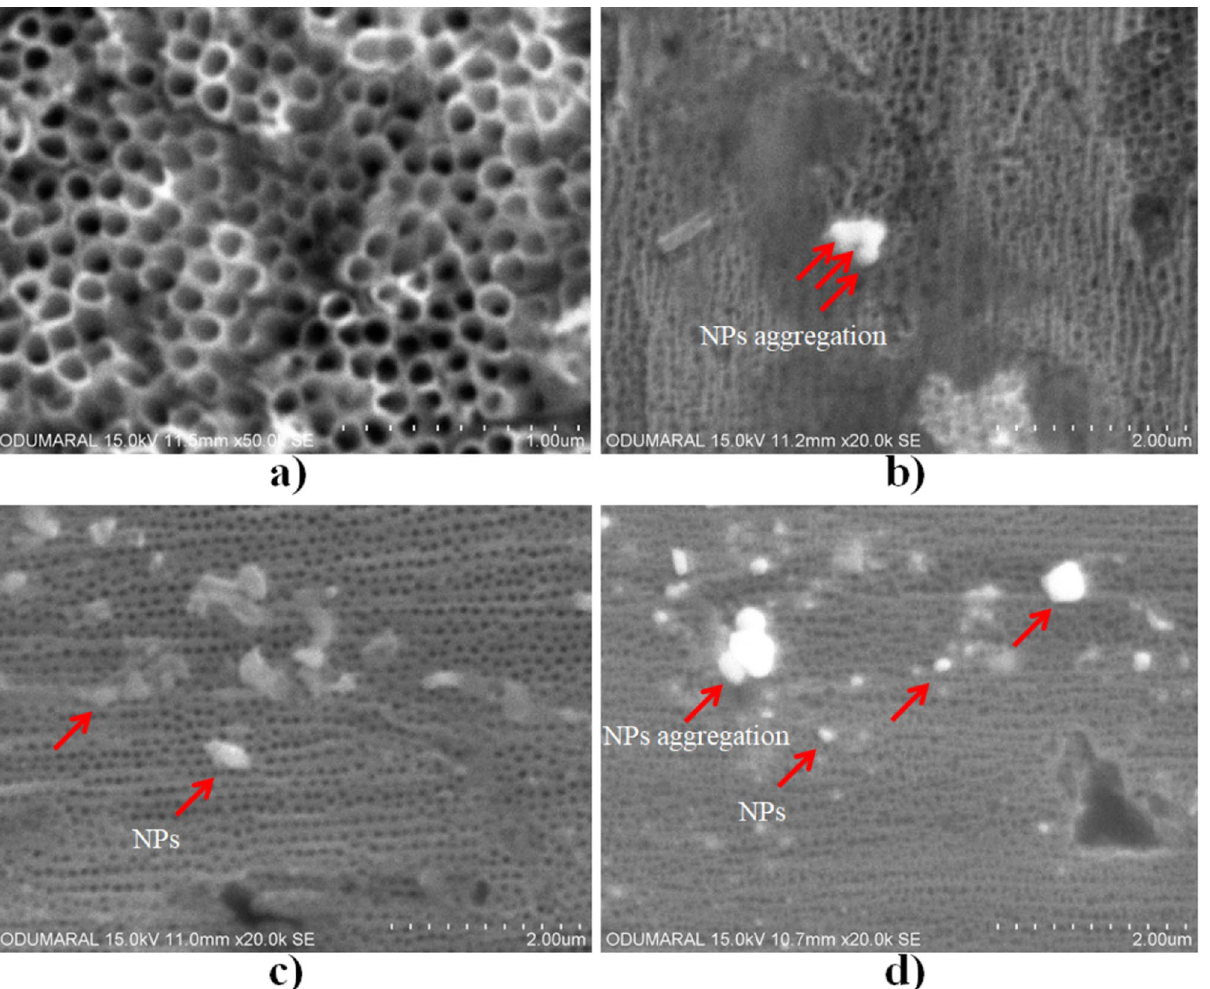
Figure 1. Surface morphologies of bare nanotube and AgNPs-deposited on nanotube surfaces at different times by ED process: ( a ) bare nanotube (50,000×), ( b ) 0.5 min, ( c ) 1 min and ( d ) 5 min.